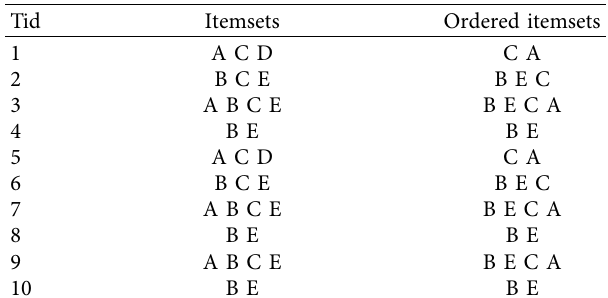
Table 5: Database D1 at